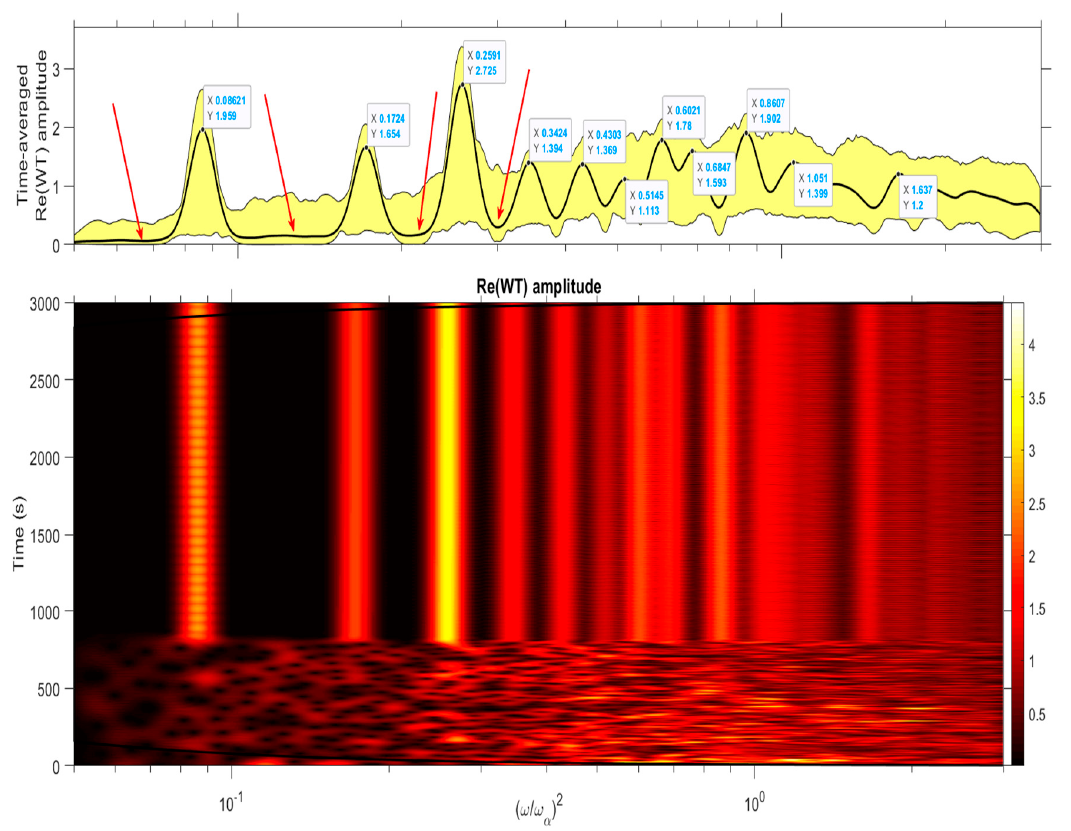
(cid:104) (cid:105) . α t ) + sin ( ht ) cos (